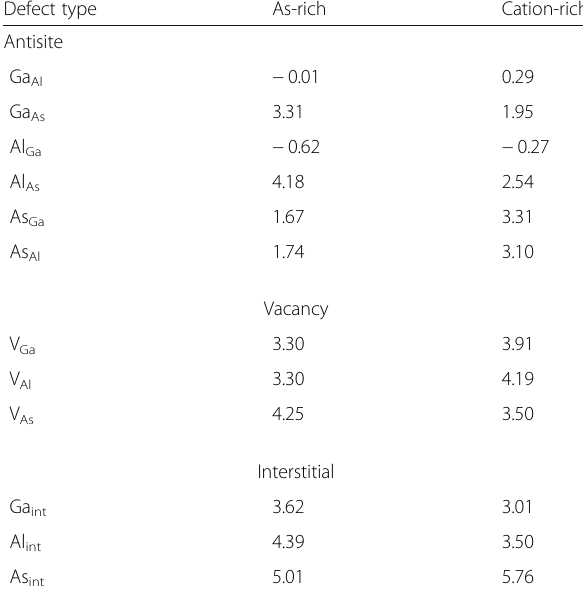
Table 3 The calculated defect formation energies (eV) in GaAs/ AlAs superlattice under cation-rich and As-rich conditions Defect